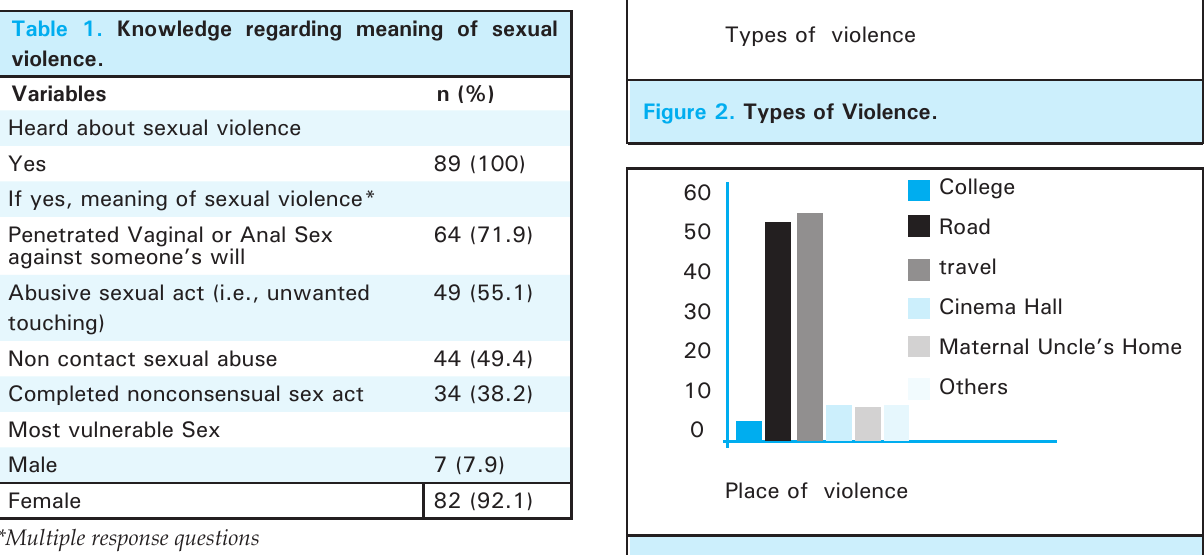
Figure 3. Place of